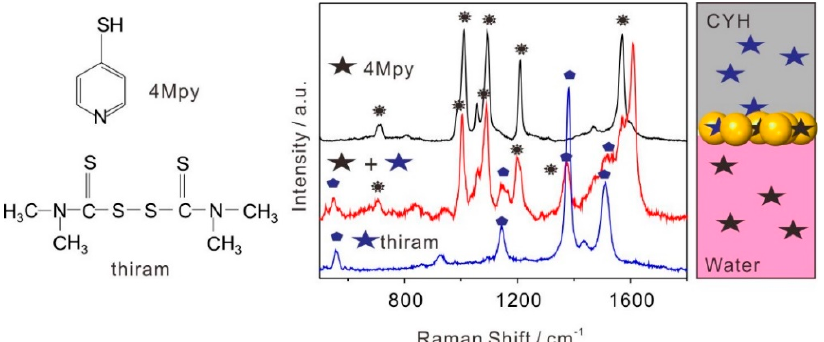
Figure 5. Self-assembly SERS platform for multiphase (red line) detection of 10 − 6 M thiram in organic phase and 10 − 6 M 4Mpy in aqueous phase. SERS spectra of sole thiram in organic phase (blue line) and sole 4Mpy in aqueous phase (black line), respectively, were measured as references. The left of Figure 5 was molecular structure of 4Mpy and thiram.